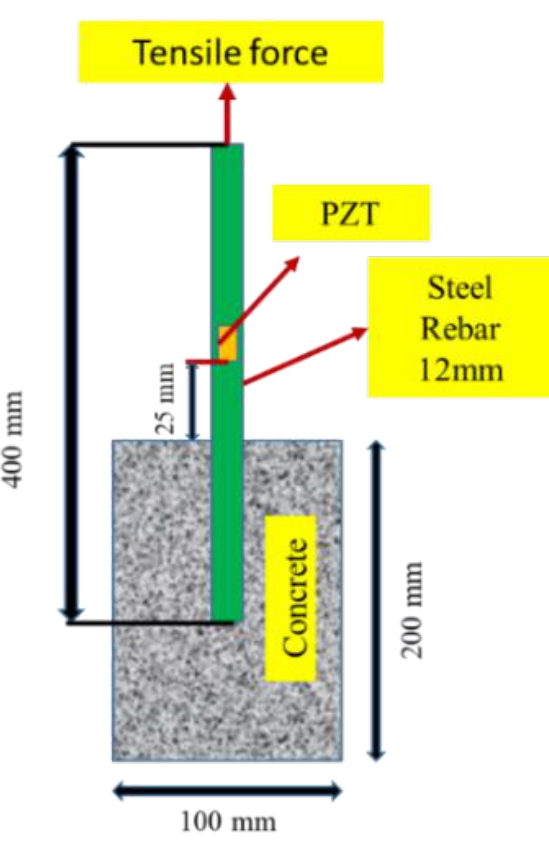
Figure 1. Specimen dimensions with PZT location.